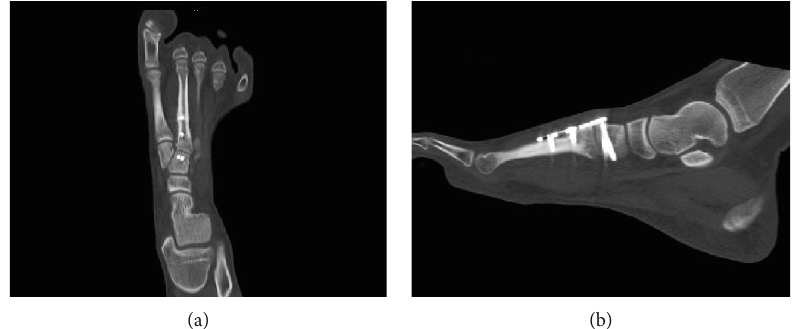
Figure 4: At 12 weeks after the operation, CT demonstrated complete bone union at the fracture site on (a) coronal and (b) sagittal views.